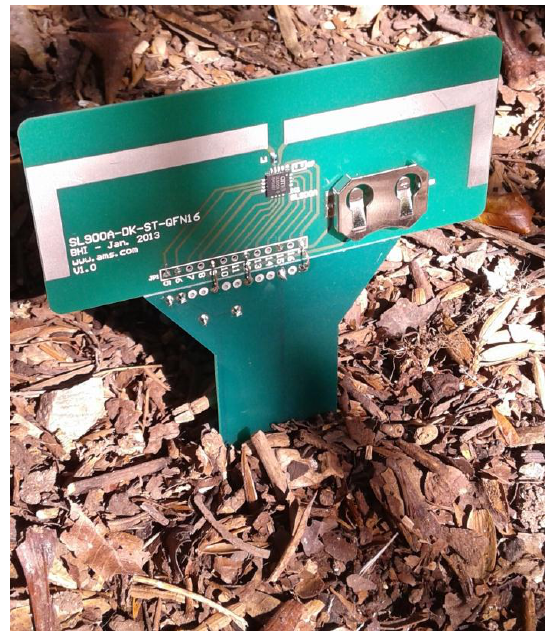
Figure 8. Example of the Soil Stick Sensor for Humidity in a real situation.